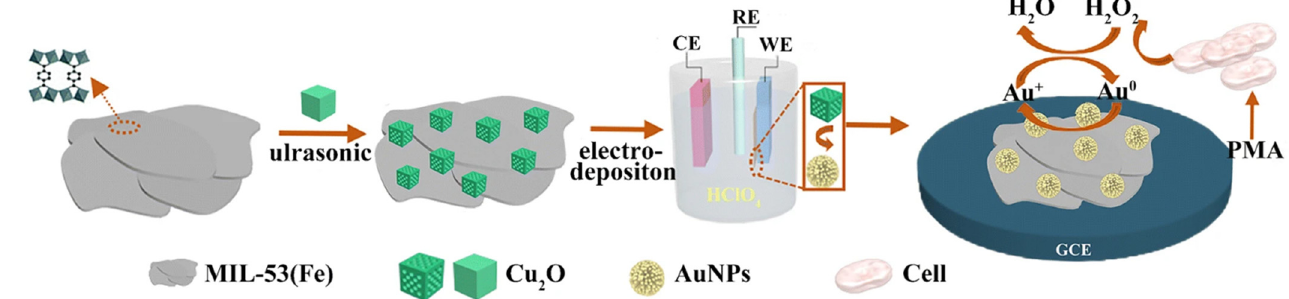
Figure 9. Schematic representation of synthesis of Cu 2 O mediated Ag/MIL-53(Fe) and real time monitoring of H 2 O 2 from living cell A549. Reprinted by permission from [Springer Nature Customer Service Centre GmbH]:[Springer Nature] [Analytical and Bioanalytical Chemistry] [Cu2O-Mediated Assembly of Electrodeposition of Au Nanoparticles onto 2D Metal-Organic Framework Nanosheets for Real-Time Monitoring of Hydrogen Peroxide Released from Living Cells, Sha Chen et al.] [COPYRIGHT 2020] (2021) [90].